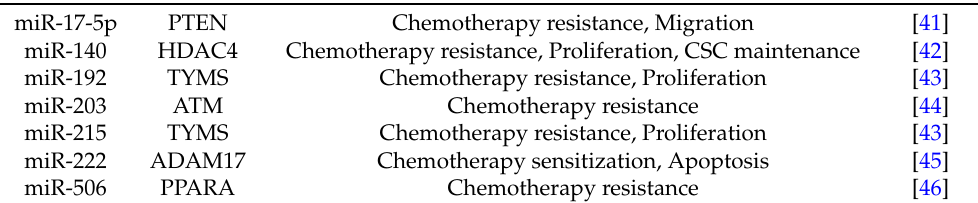
Table 3. miRNAs associated with chemotherapy